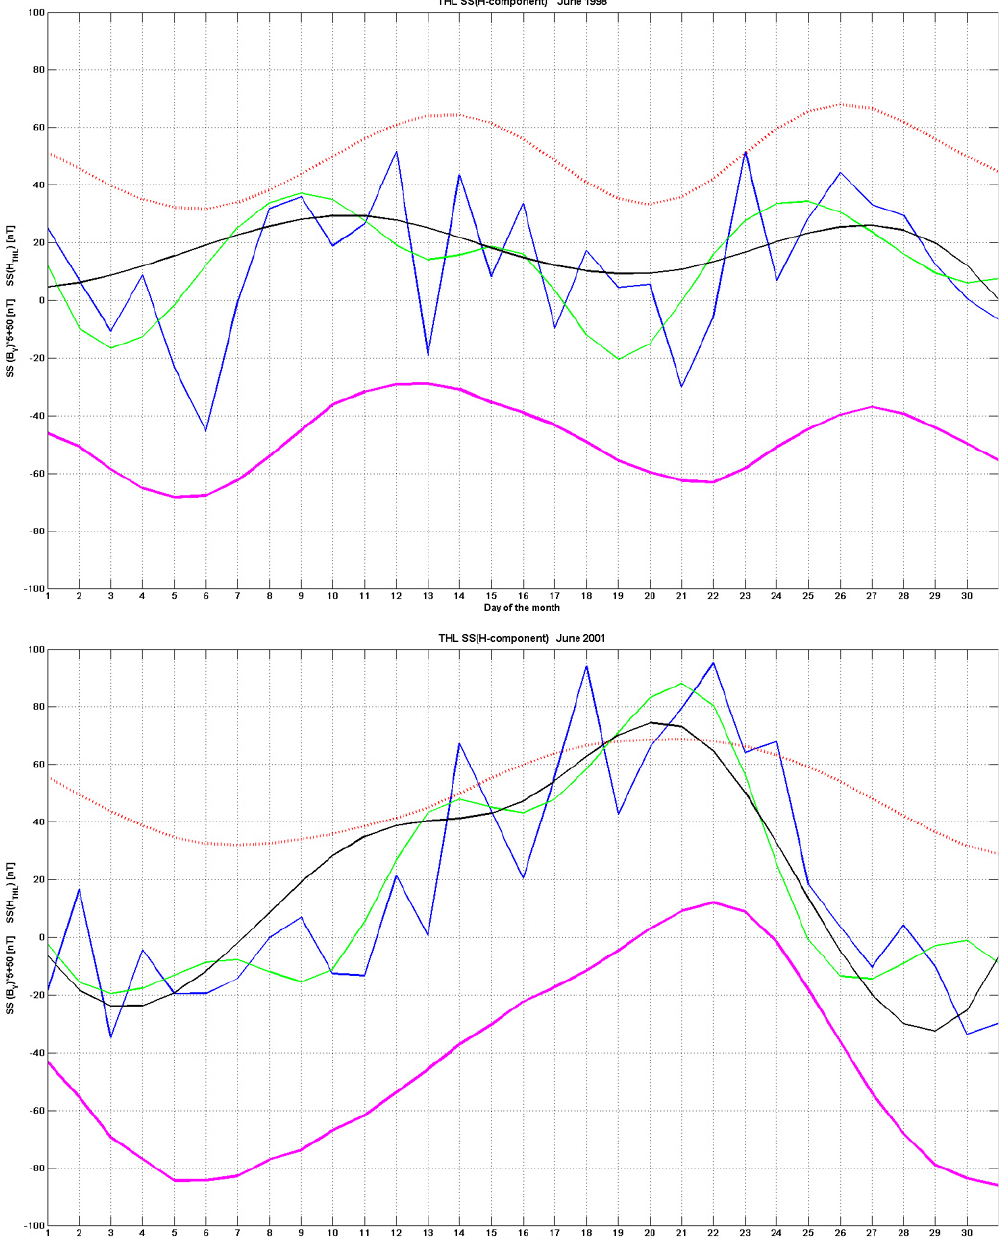
Fig. 6. Behavior of the median values of the magnetic H-component at Thule station during June months of 1998 (a) and 2001 (b) for intervals with duration of 1 day (blue line), 3 days (green line), and 5 days (black line). The red dotted line shows the variation of the IMF B y component, derived from spacecraft measurements. The magenta line shows the variation of the reconstructed magnetic H-component. To be clearly demonstrated, the actual B y values were multiplied by five and were shifted by 50nT to a higher position, whereas the curve of reconstructed H-component was shifted by 50nT to a lower position.